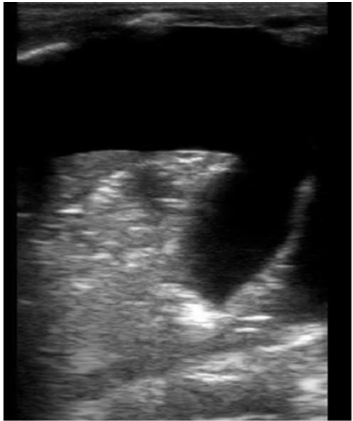
Figure 4. Large pleural effusion in B-mode. Large pleural effusion with septation and complete at- electasis of the